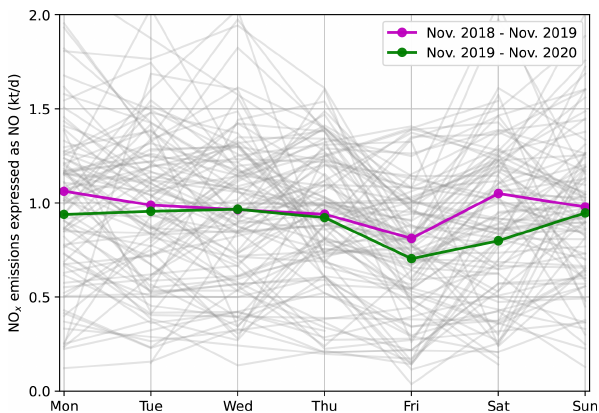
Figure 8. Weekly profiles of anthropogenic NO x emissions for Egypt using TROPOMI observations in 2018–2019 (purple line) and 2019–2020 (green line). Thin grey lines represent individual weeks. Days for which less than 80% of the domain counts low- quality observations ( q a < 0 . 75) are not